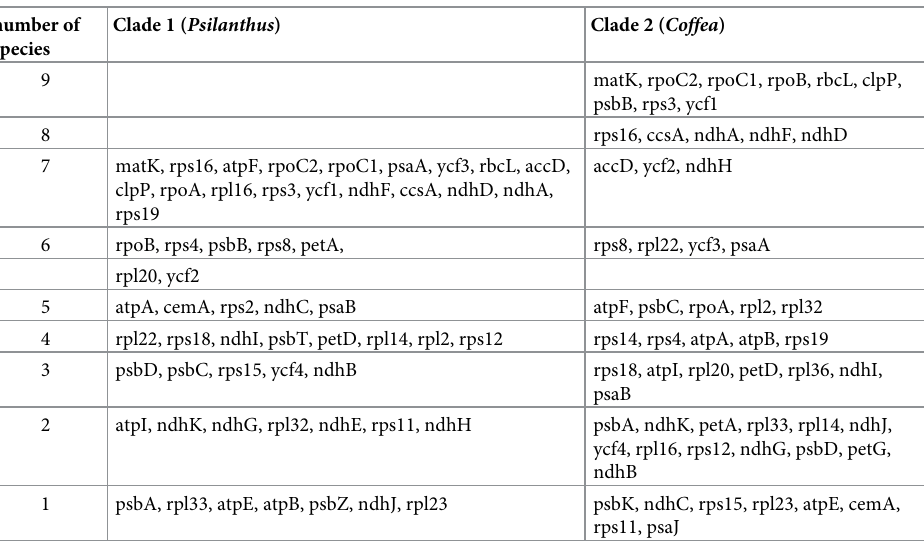
Table 2. Number of species in which one or several genes gene are different from the ancestral version. Genes have been ordered according to their variability, from highly to less variable and according to the number of species in which these genes are different from the ancestral version. For instance, all the species of Clade 1 (7) have rpl16 and rps16 different from their